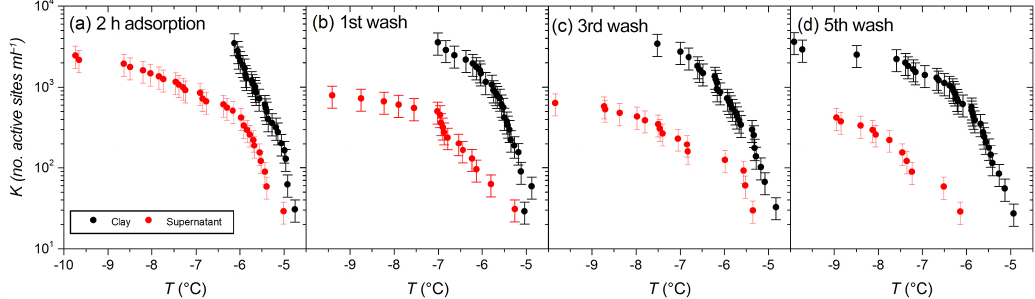
Figure 5. Effect of repeatedly washing the clay pellet by successive resuspension and centrifugation (see Fig. 1). Illustrated are (a) activities of the clay and supernatant after adsorption is allowed to proceed for 2h, and (b – d) the effects of successive washing of the clay pellet with pure water. After each washing cycle, on the order of 10% of the protein was observed to be lost to the supernatant, suggesting that the adsorption process is partially reversible. This is in addition to a maximum of 4% loss in each wash, due to the amount removed to conduct the droplet freezing